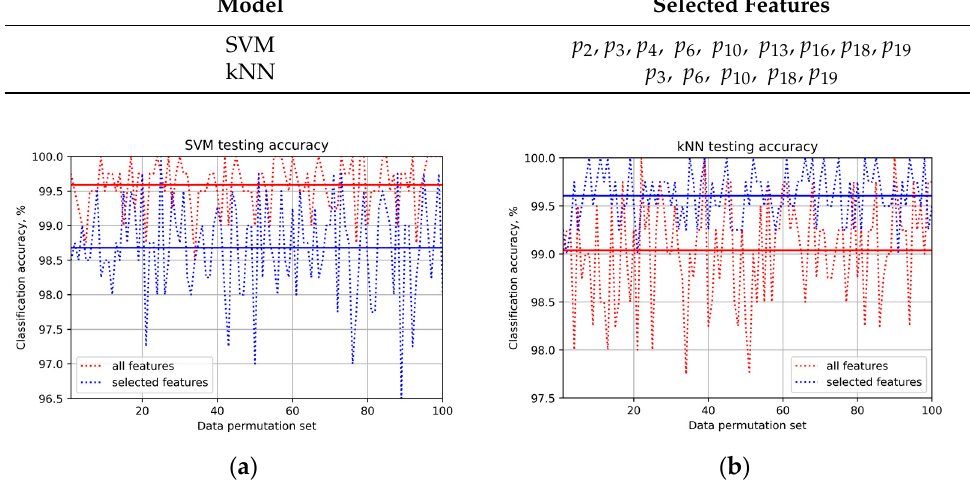
Figure 8. Test accuracy for 100 different test sets: ( a ) SVM model; ( b ) kNN model. Table 4. Most important features according to SHAP analysis.